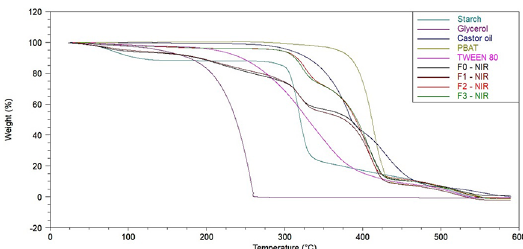
Figure 1. Thermogravimetric curve of NIR blends and their components